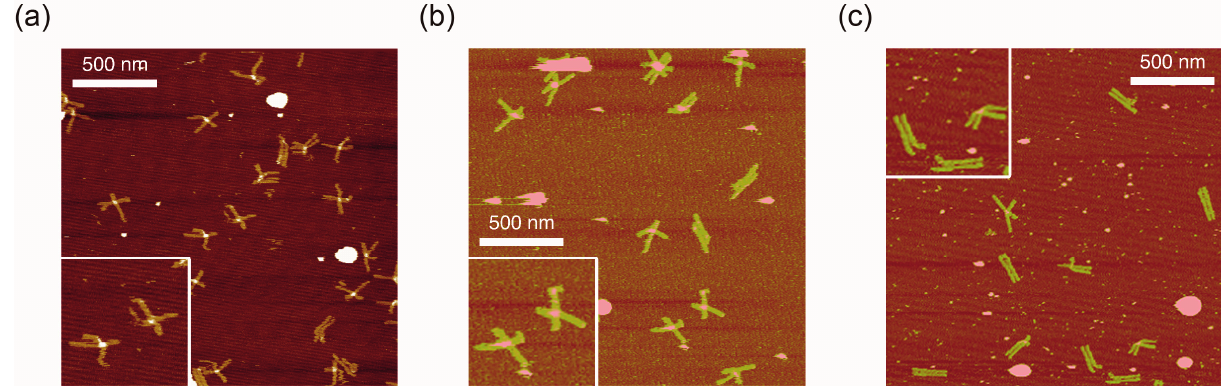
Figure 2. Atomic force microscopy (AFM) images of DNA Origami Pliers deposited on mica at pH 8.2 ( a ); pH 7.0 ( b ); and pH 5.6 ( c ). Insets: 150% magnified view of typical